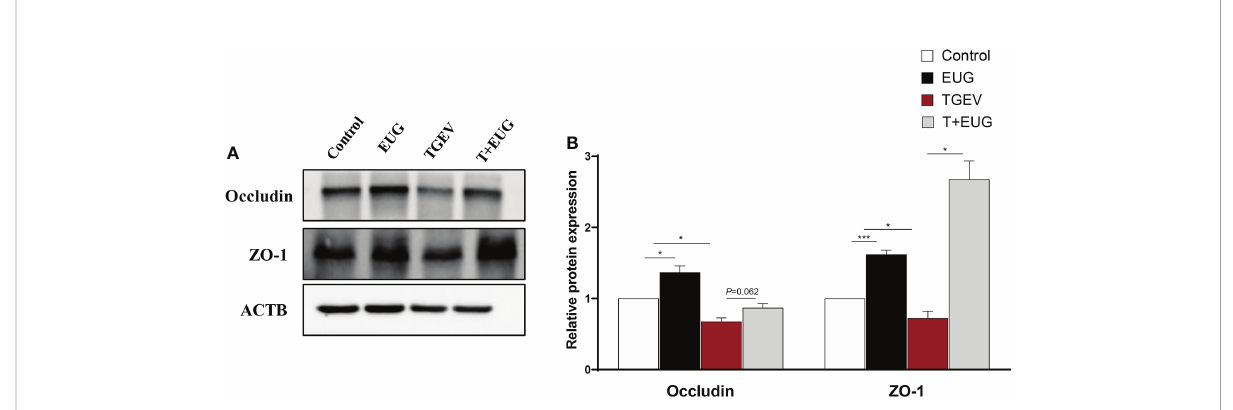
FIGURE 7 Effects of eugenol on jejunum intestinal barrier related proteins expression levels in TGEV-infected weaned piglets. (A, B) Immunoblot analysis and quanti fi cation of ZO-1 and Occludin in jejunum mucosa. Data were expressed as mean ± SEM. * p < 0.05. *** p < 0.001